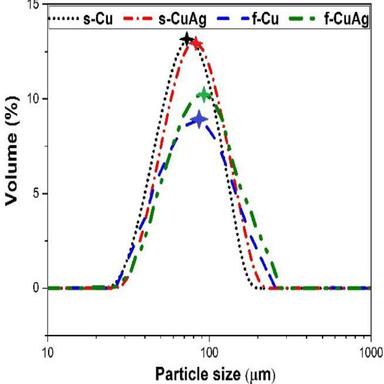
Particle size distribution of s-Cu, s-CuAg, f-Cu and f-CuAg powders.